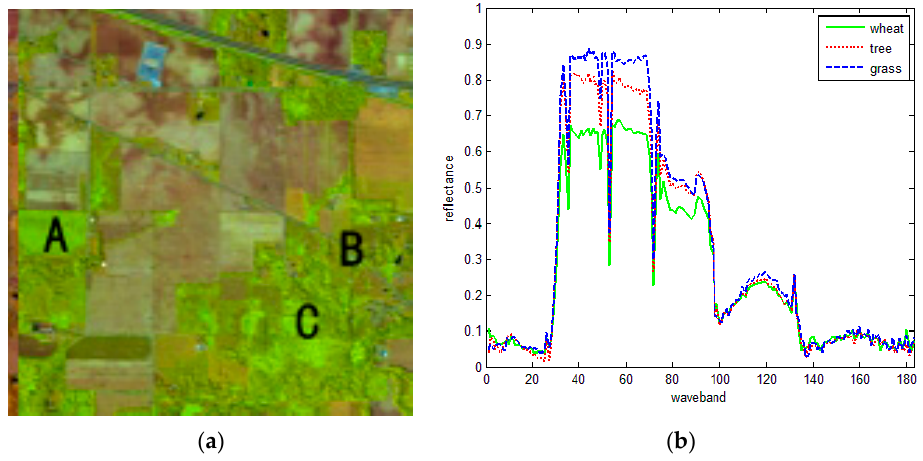
Figure 6. RGB color composite AVIRIS image. ( a ) True color image and ( b ) mean spectral curve of three types of land cover.